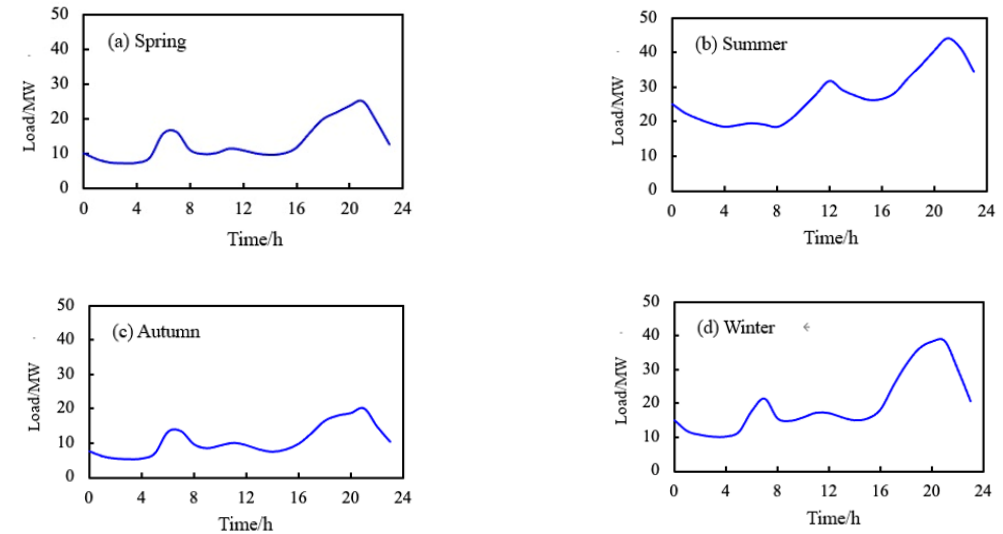
Figure 6. Hourly load changes of typical daily residents in an industrial park in different seasons. The hourly load trend of residents on a typical day is similar. The peak electricity consumption is mainly concentrated from 17:00 to 22:00. As this period is the time when residents are off work, the load in the residential area reaches the peak of the day. Due to weather changes, residential areas have increased air conditioning in summer, air conditioning and heating in winter, and the hourly load peak and valley values of residents in summer and winter are higher than those in spring and autumn. The peak difference between summer and spring is about 15 MW. The peak difference in autumn is nearly 20